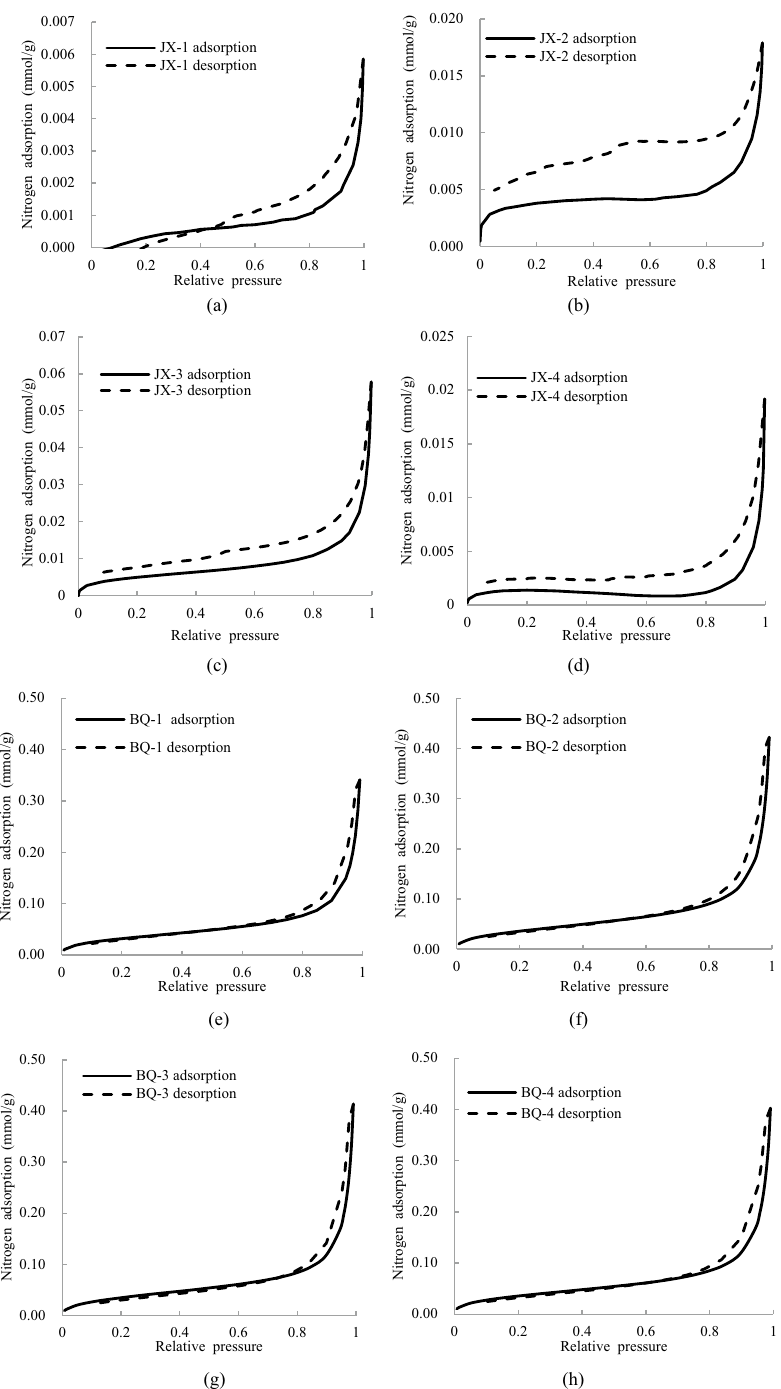
Figure 3. The isothermal adsorption/desorption curves of NA (p/p0 ≤